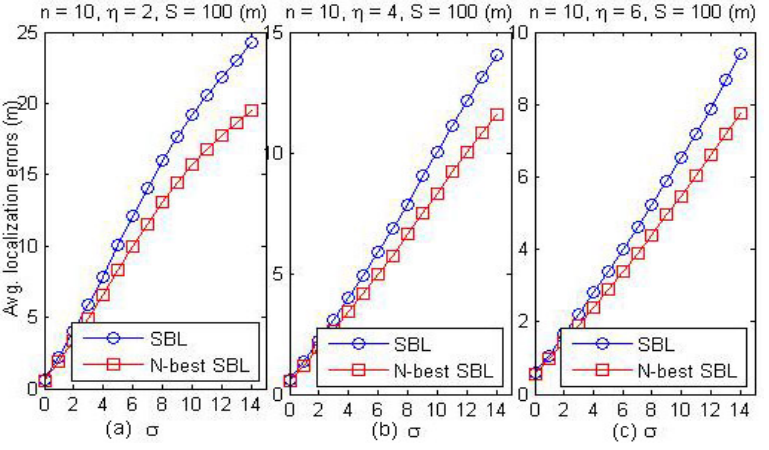
Figure 12. The performance comparison of SBL method and N -best SBL method in terms of the average localization errors for  = 2 (a),  = 4 (b), and  = 6